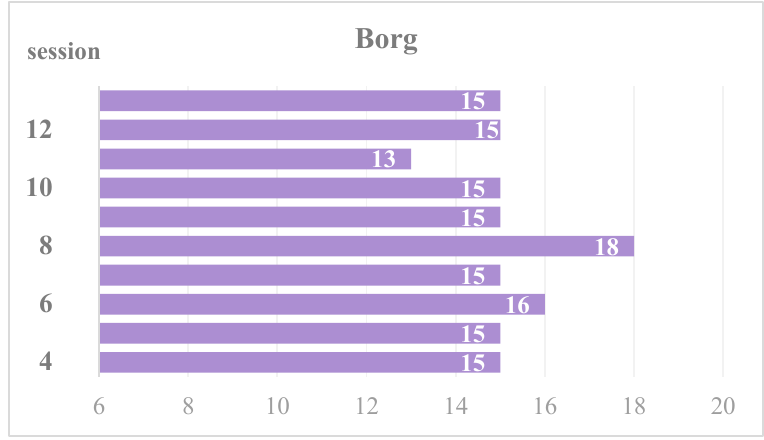
Figure 4. Trend of the BORG score.